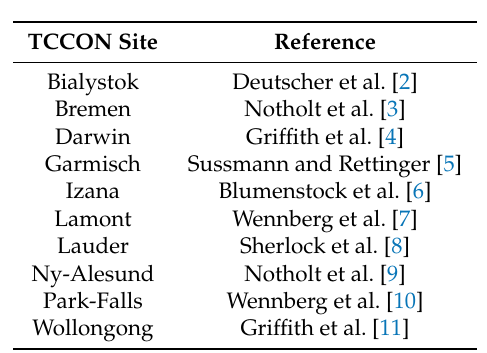
Table B1. Total Carbon Column Observing Network (TCCON) sites with the references to the data used in this